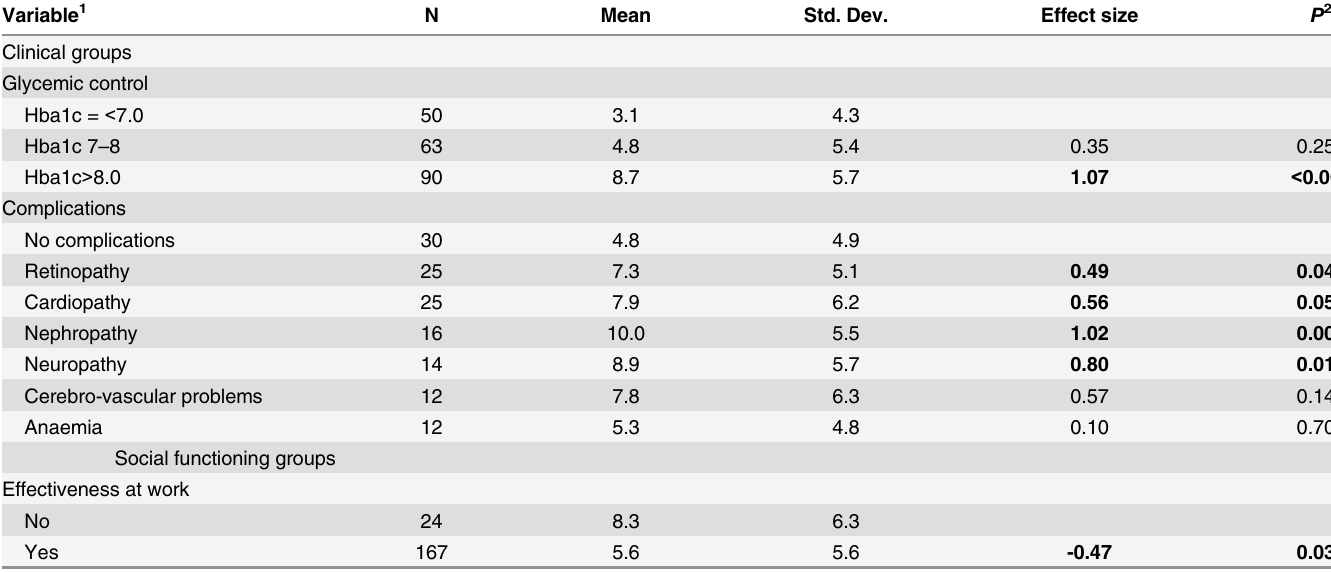
Table 3. Comparison of 16-item PAID scores across known demographic, clinical and social functioning